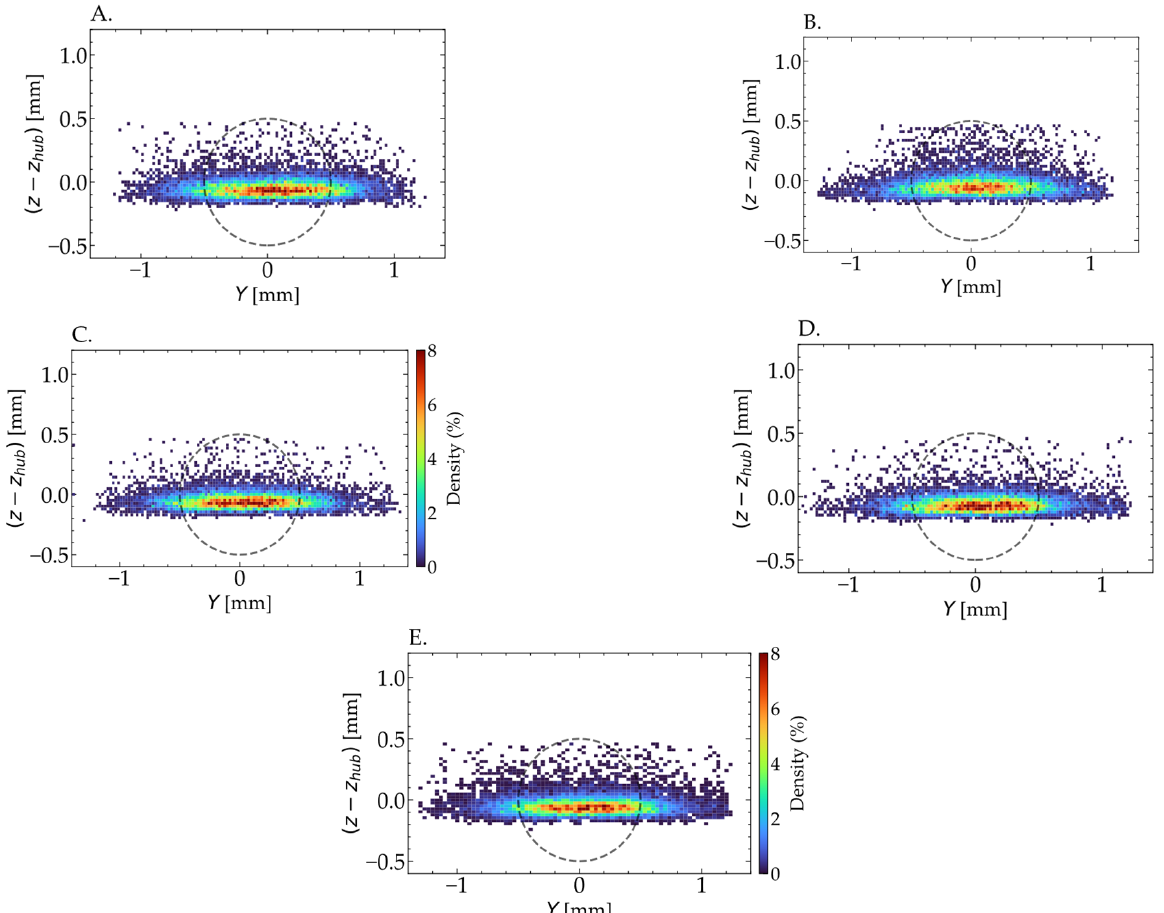
Figure 7. 2D histogram of wake centres for different test cases: ( A ) Fixed model; ( B ) Pitch f red = 0.28; ( C ) Pitch f red = 0.14; ( D ) 3DoF realistic time history; ( E ) Surge f red = 0.11.